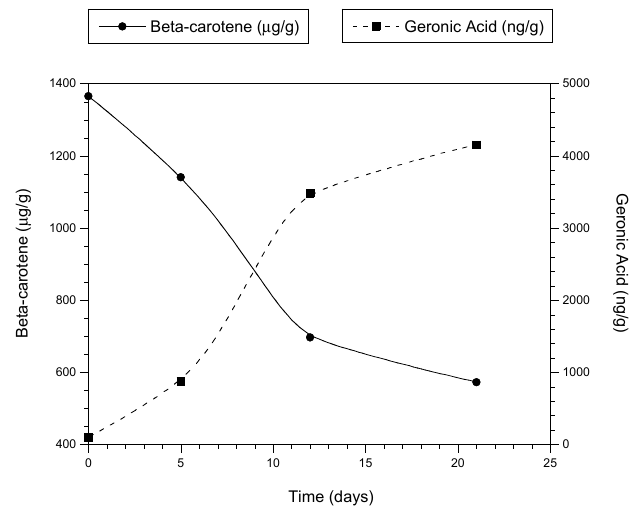
Figure 3. Formation of geronic acid as β -carotene is oxidized in dried, powdered carrot exposed to air. Measurements at time 0 used freshly dehydrated carrot purée. The dried purée was immediately ground to powder, spread thinly on a tray, and exposed to air and ambient light. Values at subsequent time points were determined using the powder.